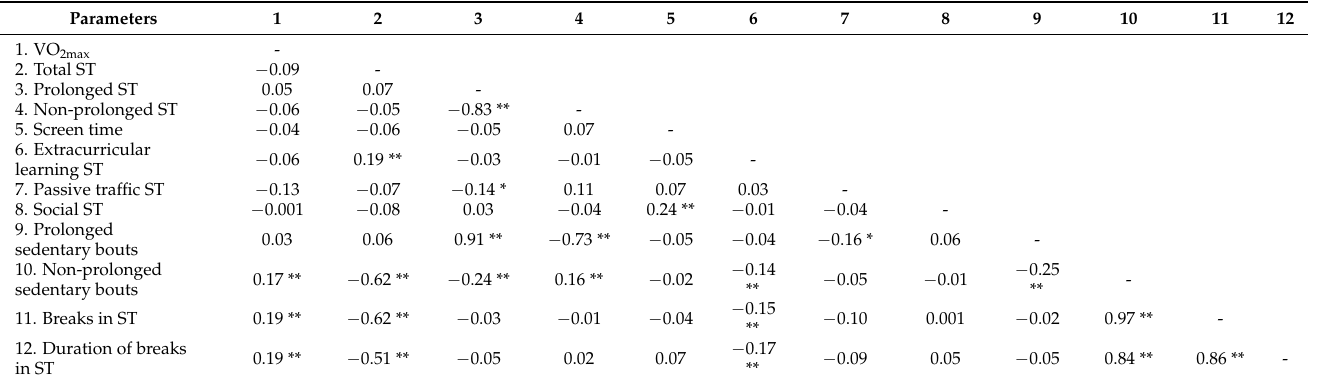
Table 3. Correlation analysis of each variable.